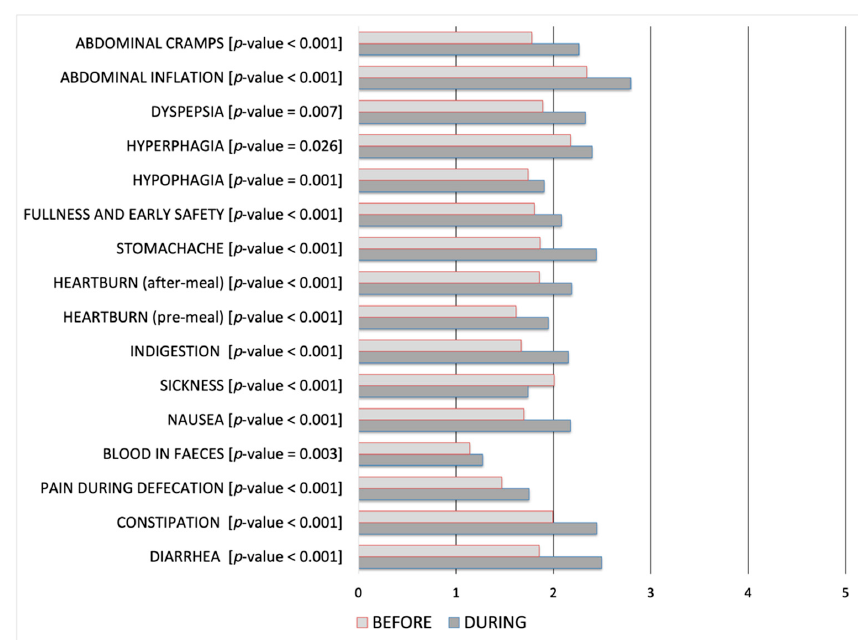
Figure 4. GISs before and during the SARS-CoV-2 lockdown period, within the range 0 (never) to 5 (always). Table 8. Correlation between psychometric parameters before and during the SARS-CoV-2 lockdown